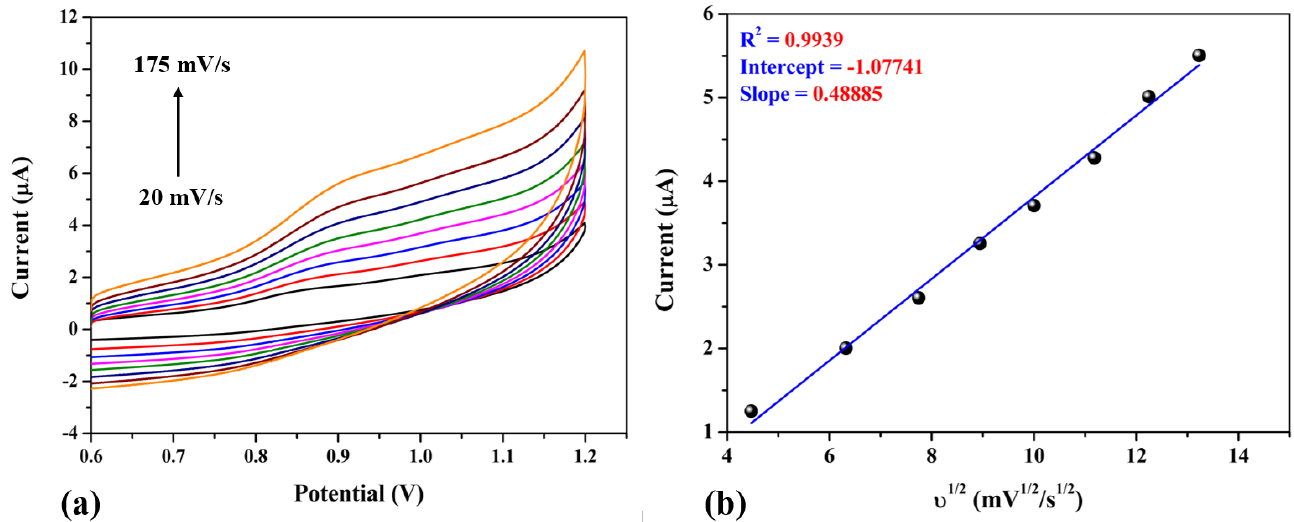
Figure 10. ( a ) CVs were recorded using Ag-NPs/GCE at different scan rates (20, 40, 60, 80, 100, 125, 150 and 175 mV/s) in 0.1 M PBS with 100 µ M NIC. ( b ) The linear plot was made between the square root of scan rate and oxidation peak currents of NIC.